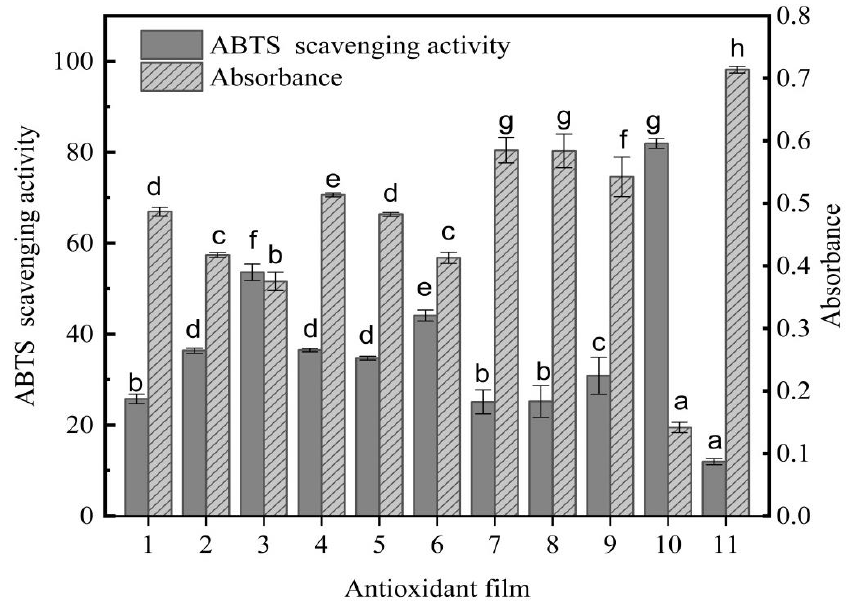
Figure 6. The antioxidant capacity of the anti-oxidative film, expressed as the percentage of ABTS radical inhibition and the absorbance at 734 nm. Different letters indicate significant differences between films ( p < 0.05).